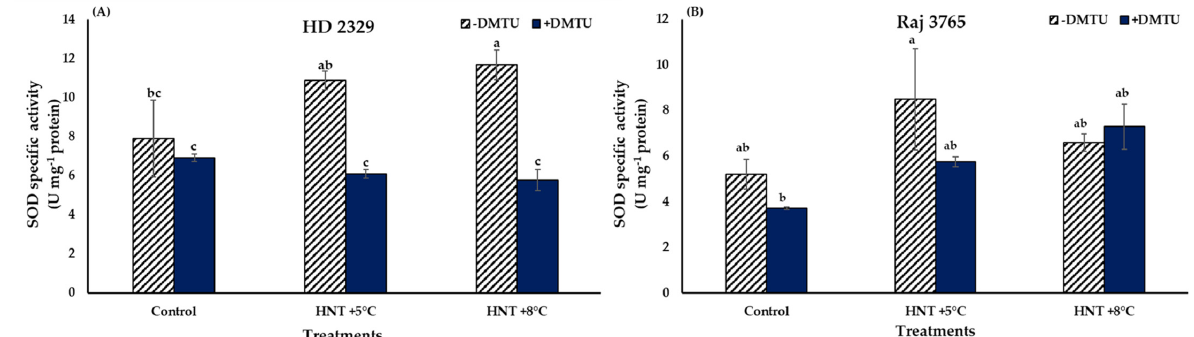
Figure 6. Effect of HNT on superoxide dismutase specific activity in pistil of wheat genotypes ( A ) HD 2329 (sensitive) and ( B ) Raj 3765 (tolerant) under control, HNT (+5 °C) and HNT (+8 °C) conditions in absence and presence of ROS scavenger (DMTU). Bars represent mean ± SE. Bars with common letter are not significantly different between temperature treatments in a genotype at p < 0.05.